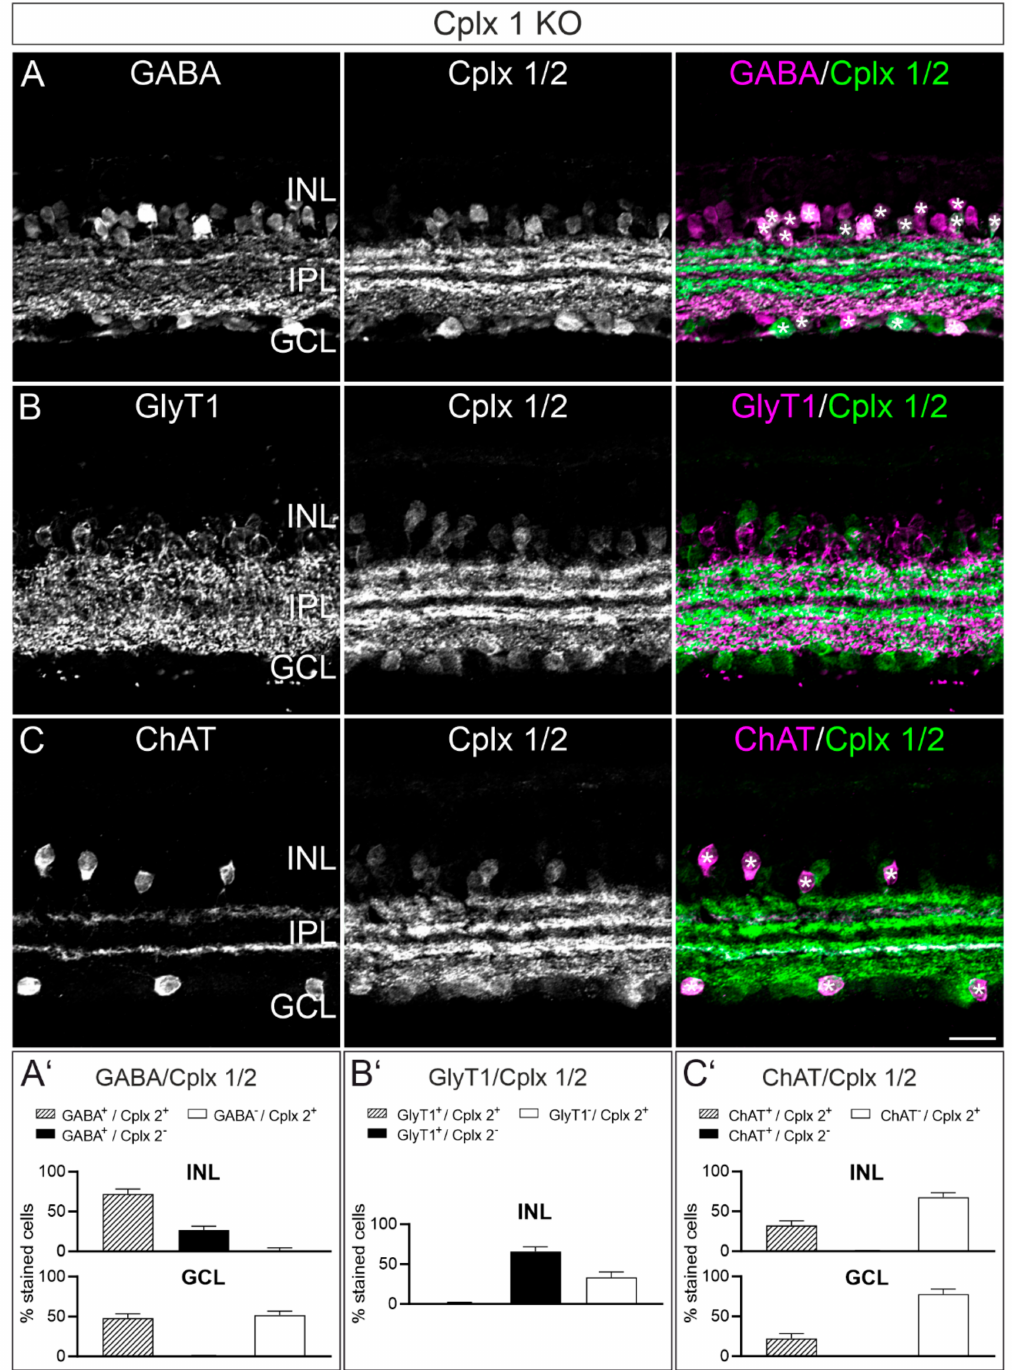
Figure 6. Expression of Cplx 2 in different amacrine cell types in mouse retinae. ( A – C ) Fluorescence micrographs of vertical cryostat sections through retinae of Cplx 1 knockout (KO) mice double labeled with antibodies against Cplx 1/2 and the amacrine cell markers γ -aminobutyric acid (GABA; ( A )), glycine transporter 1 (GlyT1; ( B )) and choline acetyltransferase (ChAT; ( C )). White asterisks mark the colocalization of Cplx 2 with GABA ( A ) and ChAT ( C ) in cell somata in the inner nuclear layer (INL) and ganglion cell layer (GCL). No colocalization of Cplx 2 and GlyT1 ( B ). ( A (cid:48) – C (cid:48) ) Quantification of stained cell somata in the INL and GCL. Sum of all stained cell somata = 100%; number of analyzed cells for ( A (cid:48) ) 674 (INL) and 536 (GCL); ( B (cid:48) ) 731 (INL); and ( C (cid:48) ) 333 (INL) and 442 (GCL). Bar graphs display the mean percentages ± SD in three animals per double labeling experiment. IPL, inner plexiform layer. Scale bar = 20 µ m in ( C ) for ( A – C